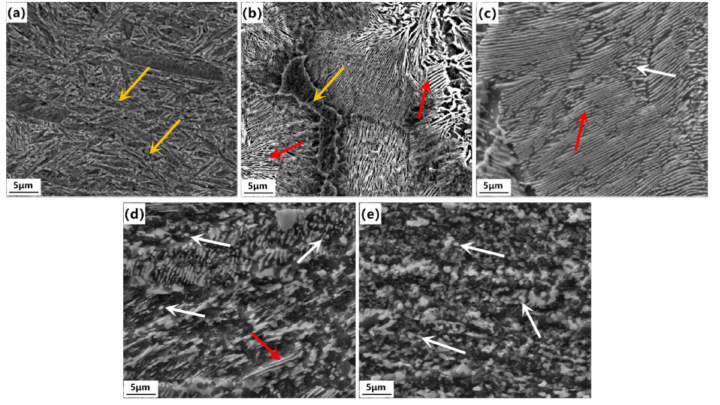
Figure 2. SEM microstructures at different deformation strains: ( a ) 0%, ( b ) 20%, ( c ) 40%, ( d ) 60%, ( e )